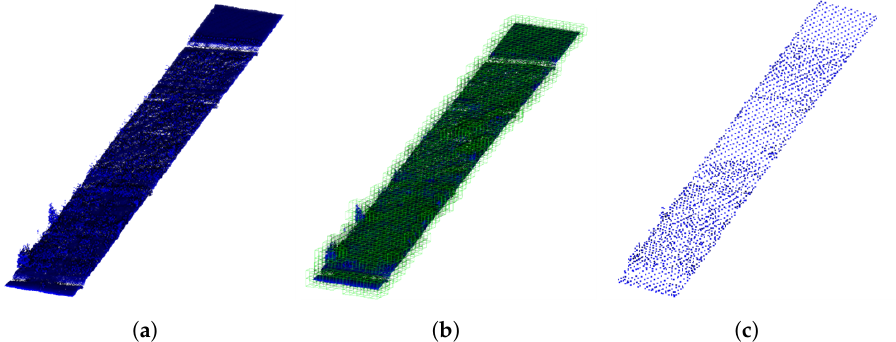
Figure 4. Ground point downsampling. ( a ) original ground point cloud; ( b ) an Octree space division of the ground points; ( c ) downsampling the ground points.